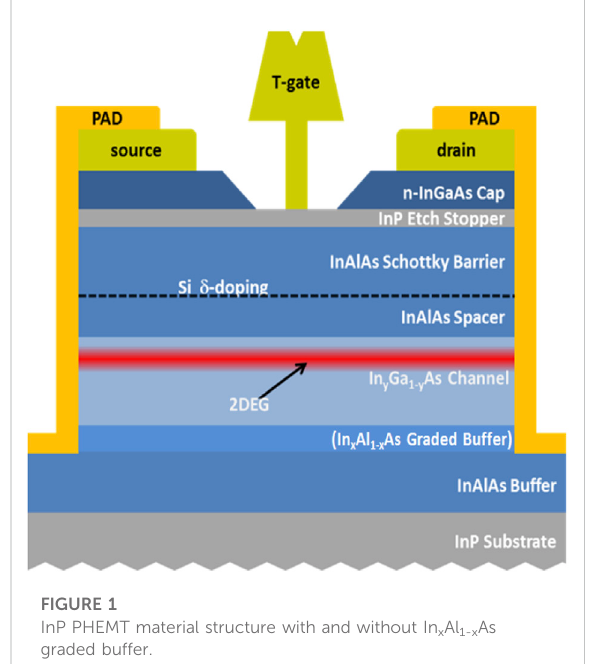
FIGURE 1 InP PHEMT material structure with and without In x Al 1-x As graded buffer.